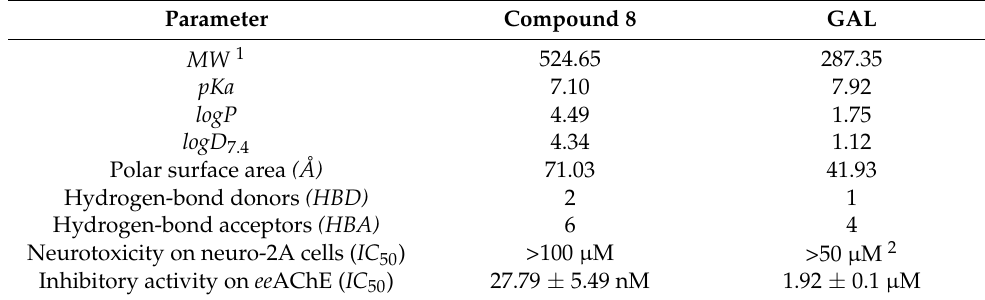
Table 2. Physicochemical properties, neurotoxicity and anti-AChE activity of compound 8